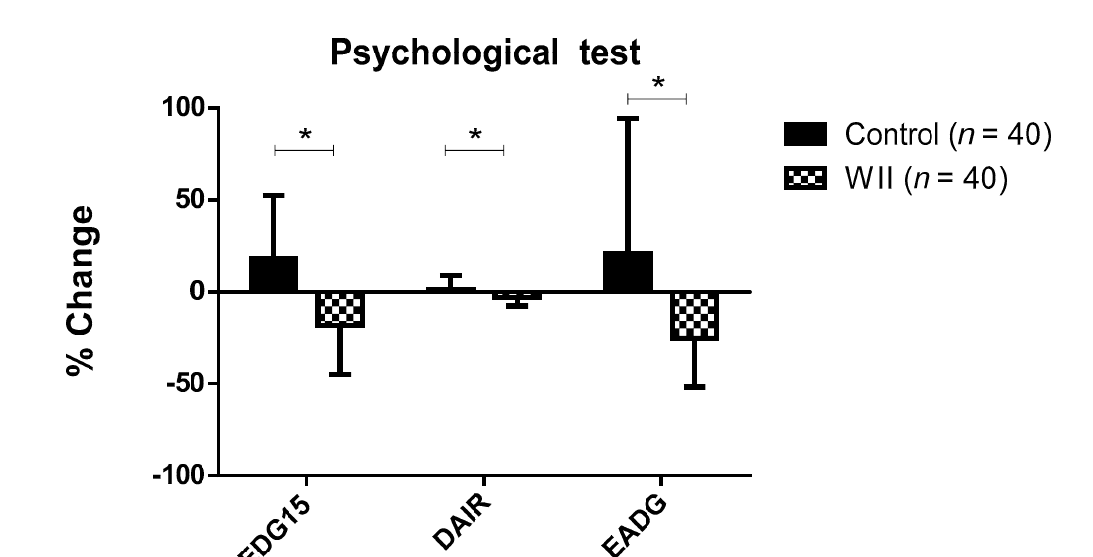
Figure 3. Change percentage during the study in both groups on psychological test variables; data are expressed as the mean ± standard deviation (SD); * Significant differences between groups ( p < 0.001).